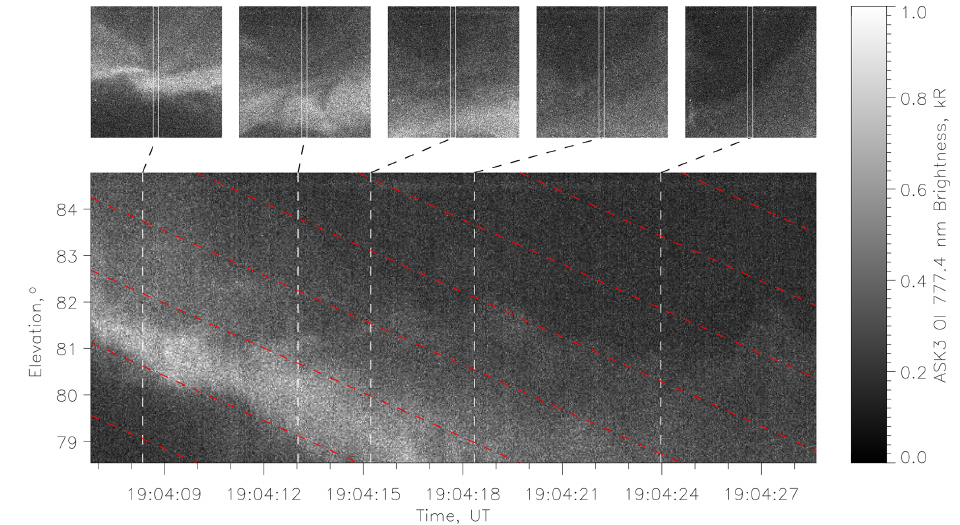
Figure 6. Keogram made using a vertical cut through the centre of the ASK3 (OI 777.4nm) field of view to show the movement of the auroral arc during event 1. White dashed lines mark the times of the images shown above the keogram. The white boxes indicated in the images show the location of the keogram cut. Red dashed lines indicate the arc motion, with their slope corresponding to the arc’s speed in the vertical cut direction.